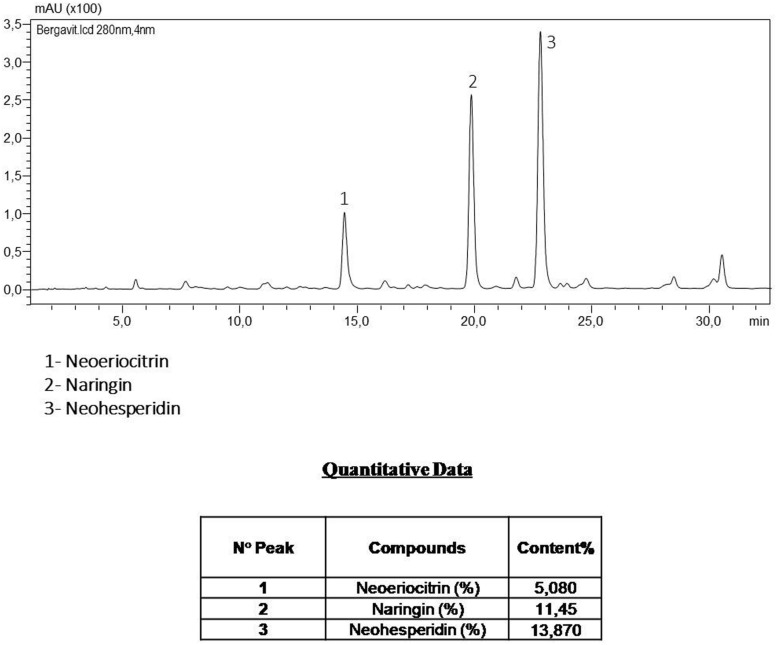
The components of Bergavit® separated by high-performance liquid chromatography (HPLC-DAD Analysis 280 nm), as determined by Bionap. The chromatographic analyses are determined on a Shimadzu LC system by Bionap.